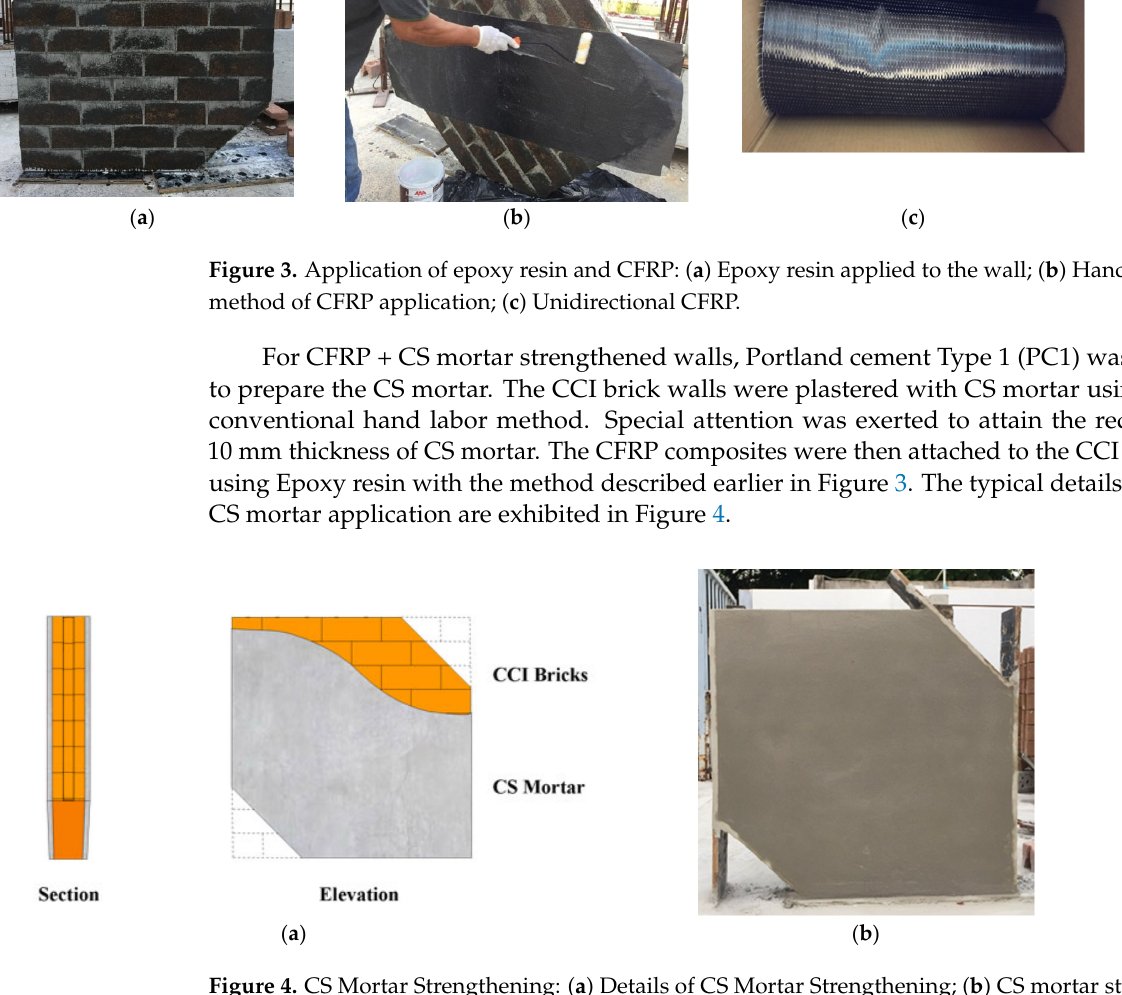
Figure 4. CS Mortar Strengthening: ( a ) Details of CS Mortar Strengthening; ( b ) CS mortar strength- ened